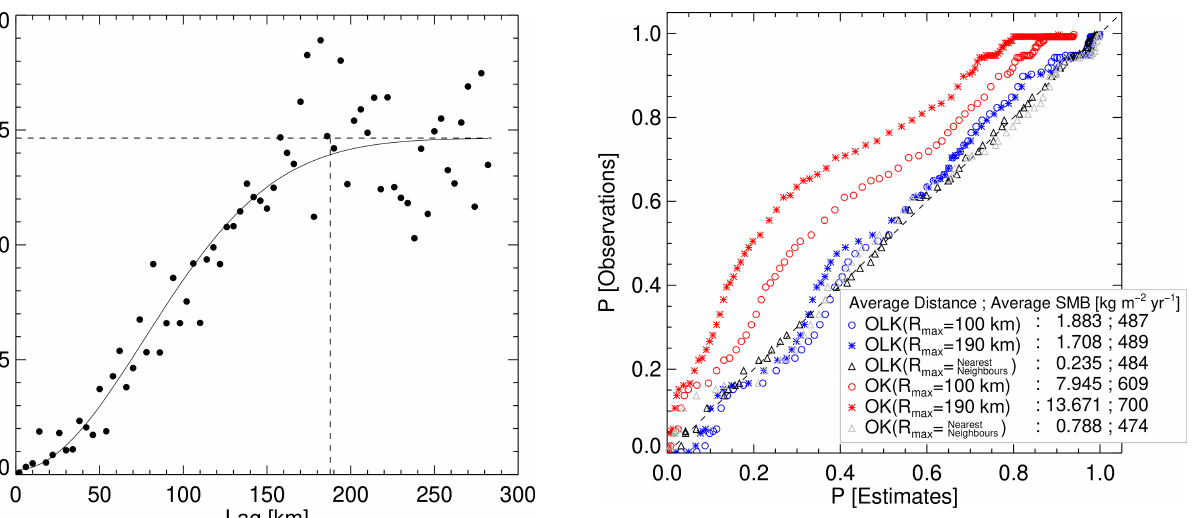
Figure 7. PP plots between SMB observations and estimates based on OK and OLK interpolation methods for varying thresholds of their maximum distance R max . The dashed 1 : 1 line indicates the complete PP agreement between observations and estimates. Average PP distances (see main text for definition) and SMB values are shown in the